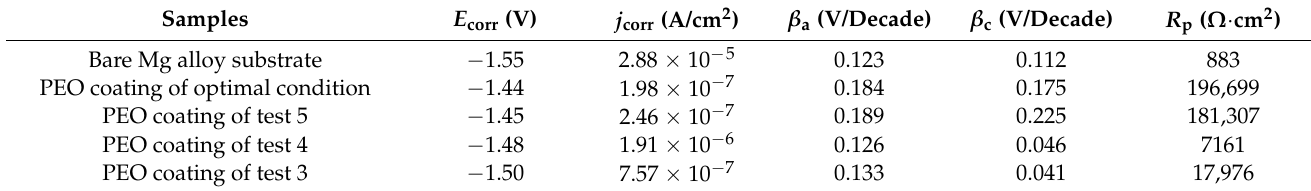
Figure 9. Potentiodynamic polarization behavior of anodic-coated and bare AZ31B Mg alloy. Elec- trolyte compositions of 45 g/L NaOH, 50 g/L Na 2 SiO 3 and 90 g/L Na 2 B 4 O 7 for test 5, 30 g/L NaOH, 70 g/L Na 2 SiO 3 and 90 g/L Na 2 B 4 O 7 for test 3 and 45 g/L NaOH, 30 g/L Na 2 SiO 3 70 g/L Na 2 B 4 O 7 . Optimal conditions are: electrolyte compositions of 45 g/L NaOH, 50 g/L Na 2 SiO 3 and 90 g/L Na 2 B 4 O 7 with electric parameters of current density 1 A/dm 2 ; pulse frequency 200 Hz; duty cycle 10% and oxidation time 15 min. Table 5. Electrochemical parameters related to potentiodynamic polarization curves for PEO coatings formed in various electrolytes and electric